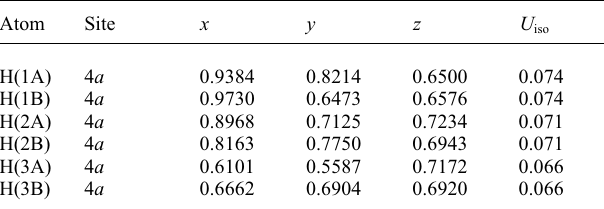
Table 2. Atomic coordinates and displacement parameters (in Å 2 )